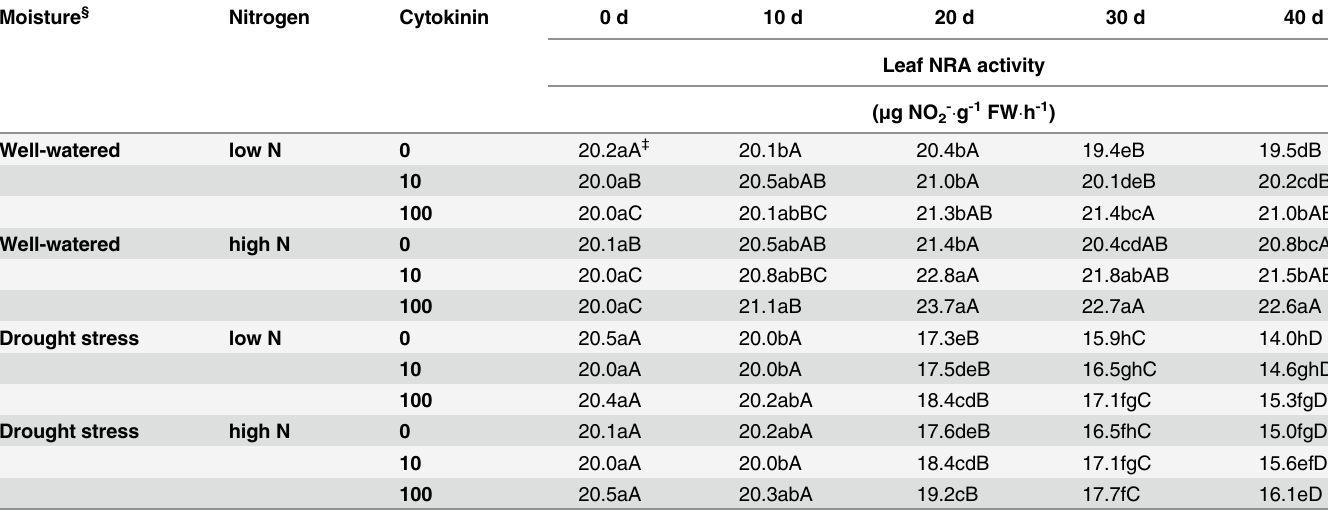
Table 4. Cytokinin and nitrogen impact on leaf nitrate reducrase (NRA) activity of creeping bentgrass subjected to two moisture